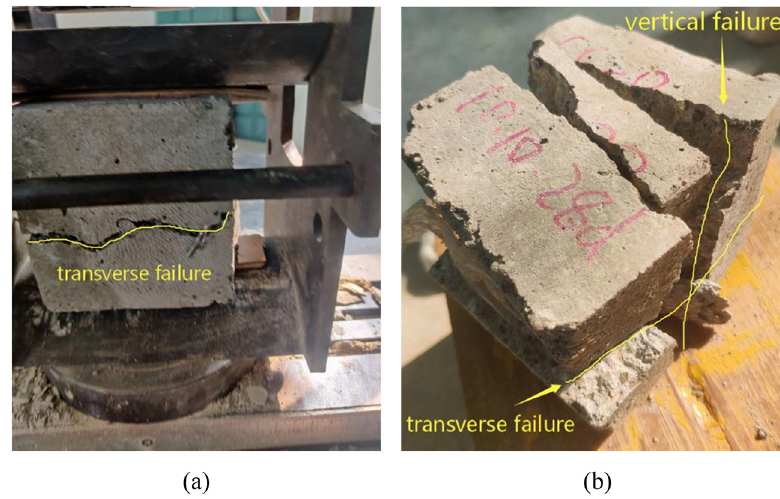
Figure 10: Benchmark group. ( a ) During fracturing and ( b ) complete